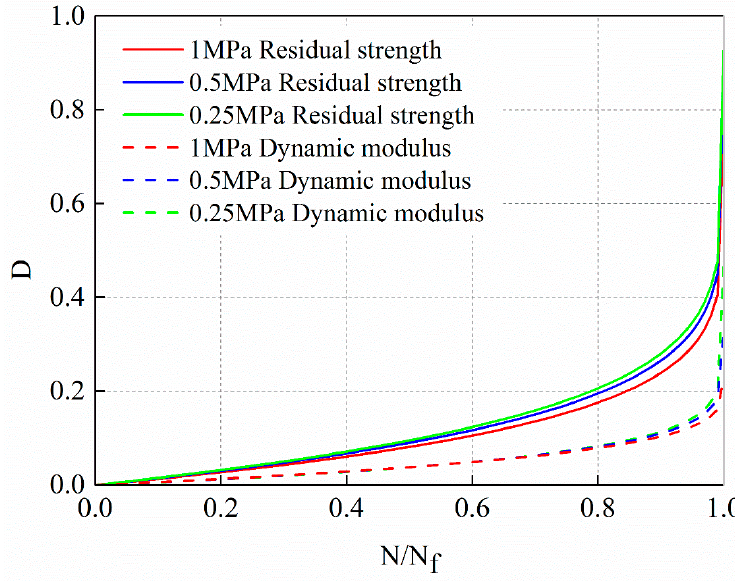
Figure 22. Comparison of damage evolution curves based on dynamic modulus decay and residual strength decay.